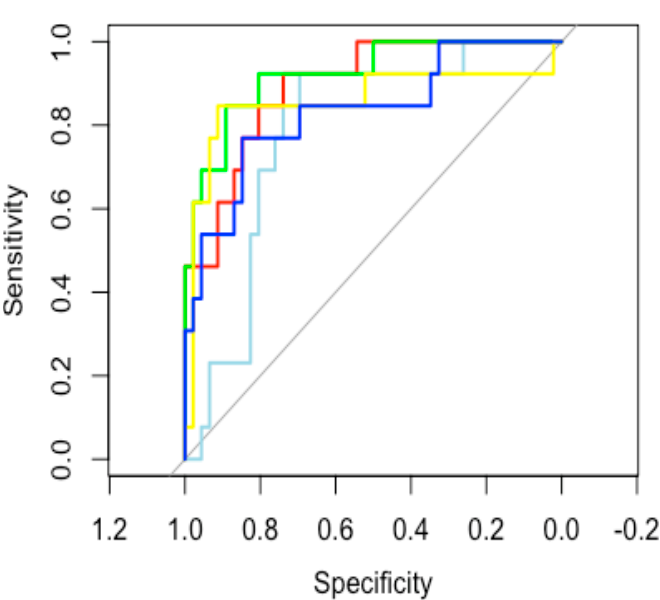
Figure 2. Glioma grading AUC values for each DKI metric. ROC analysis (pHGG = 1) yielded the following AUC values: MK (green curve): 0.9231 (95%CI: 0.840–1), AK (red curve): 0.8946 (95%CI: 0.806–0.982), RK (yellow curve): 0.8595 (95%CI: 0.706–1), FA (light blue curve): 0.7843 (95%CI: 0.656–0.912), ADC (blue curve): 0.8328 (95% CI: 0.698–0.967). DKI: diffusion kurtosis imaging; MK: mean kurtosis ;AK: axial kurtosis. RK: radial kurtosis.